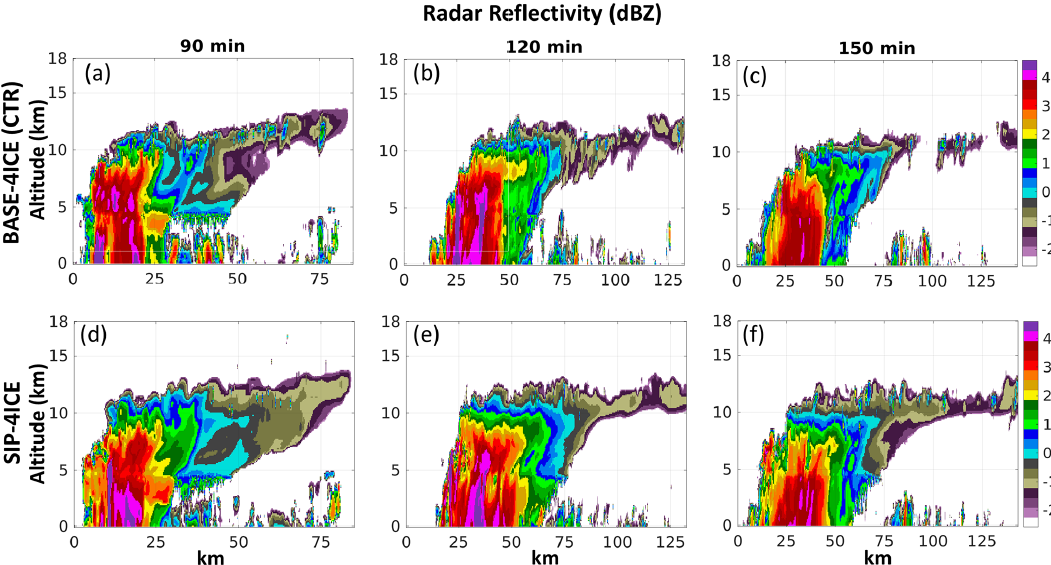
Figure 11. Simulated radar reflectivity for the cross sections indicated by the black lines in Fig.